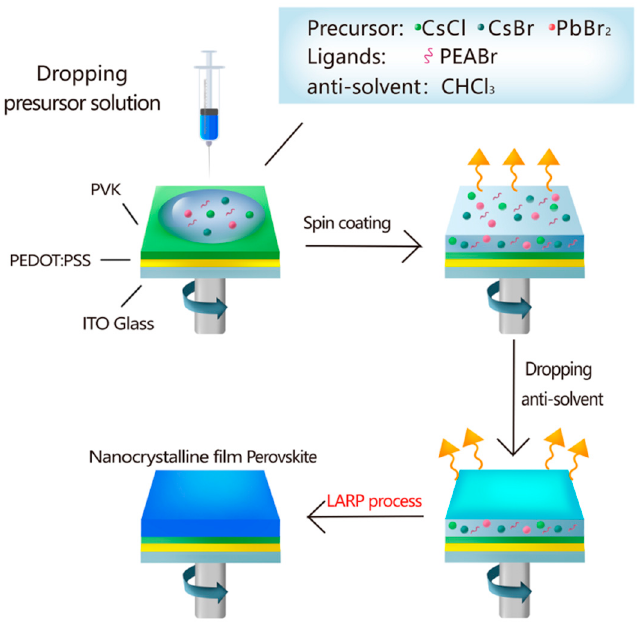
Figure 1. Schematic illustration of the in situ LARP to fabricateCsPbCl 0.75 Br 2.25 PNC films.